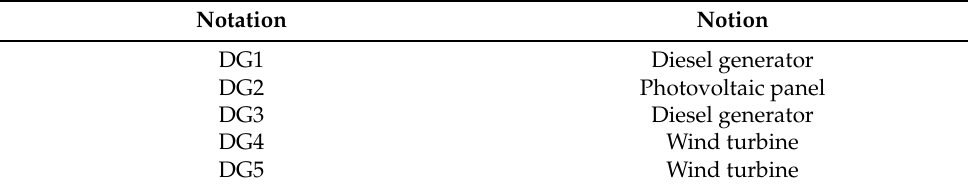
Table 1. The distribution of